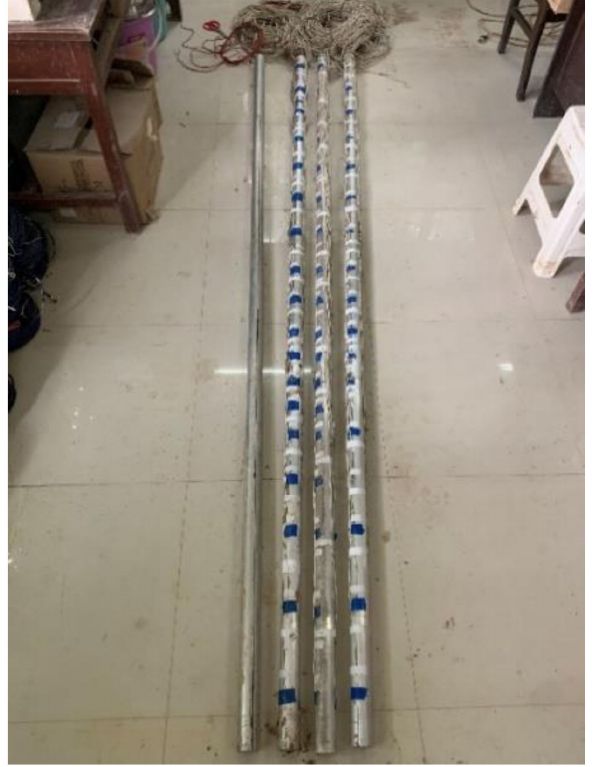
Figure 4. Micro steel piles used for the